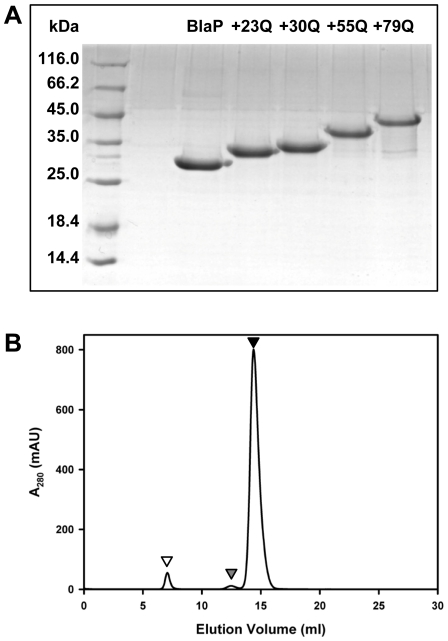
Purification of BlaP and the chimeras.(A) Purified BlaP and polyQ-containing chimeras separated on a 15% (w/v) SDS-polyacrylamide gel and stained with coomassie blue. First lane on the left shows protein markers with molecular masses as indicated, whereas the other lanes show BlaP and the various chimeric proteins as indicated. Expected molecular masses are 30 368, 33 315, 34 212, 37 416 and 40 491 Da for BlaP and chimeras with 23, 30, 55 and 79 glutamines, respectively. (B) SEC analysis of BlaP(Gln)79 at 120 µM in PBS, pH 7.5; mAU, milli-absorbance units. Monomeric, dimeric and high molecular weight species are indicated by black, grey and white arrows, respectively. The high molecular weight oligomeric species are eluted in the void volume of the column.